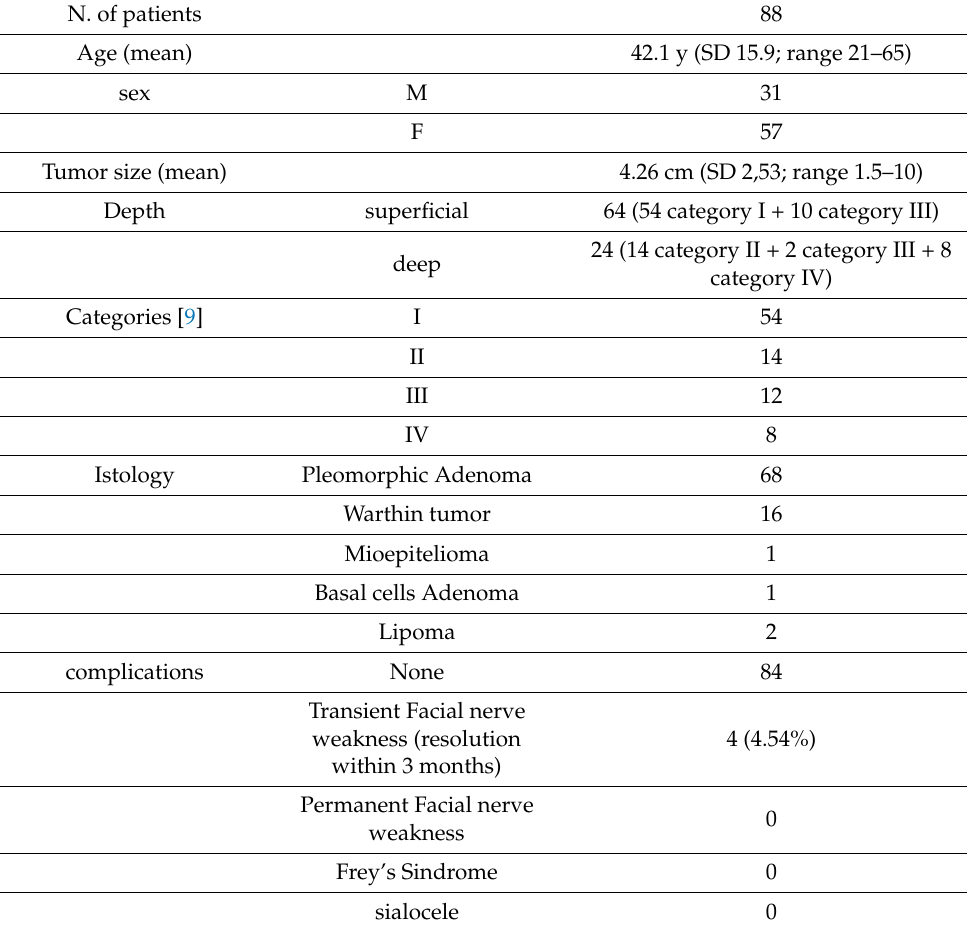
Table 1. Resumed descriptive results.